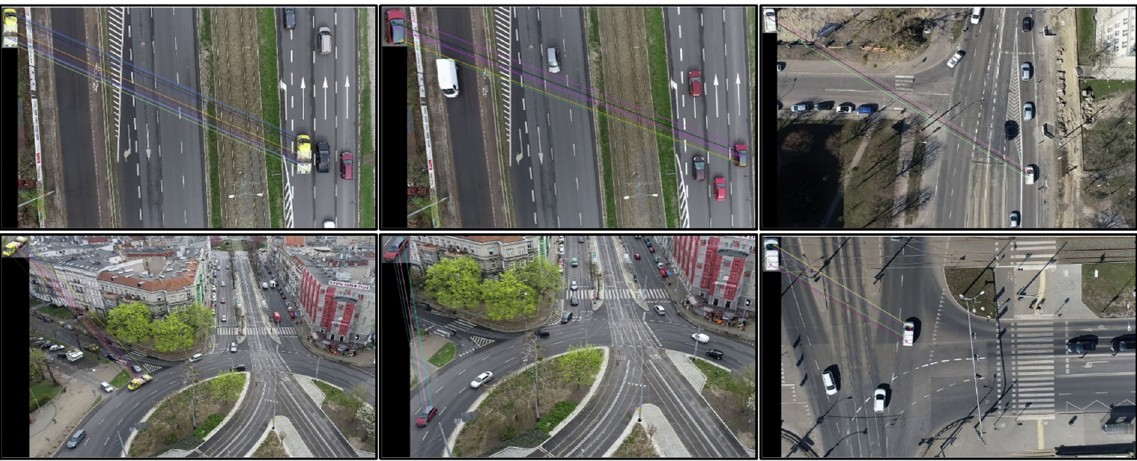
Figure 6. Example results of image analysis for the automatic detection of moving vehicles. Upper image—camera1; Lower image—camera2.